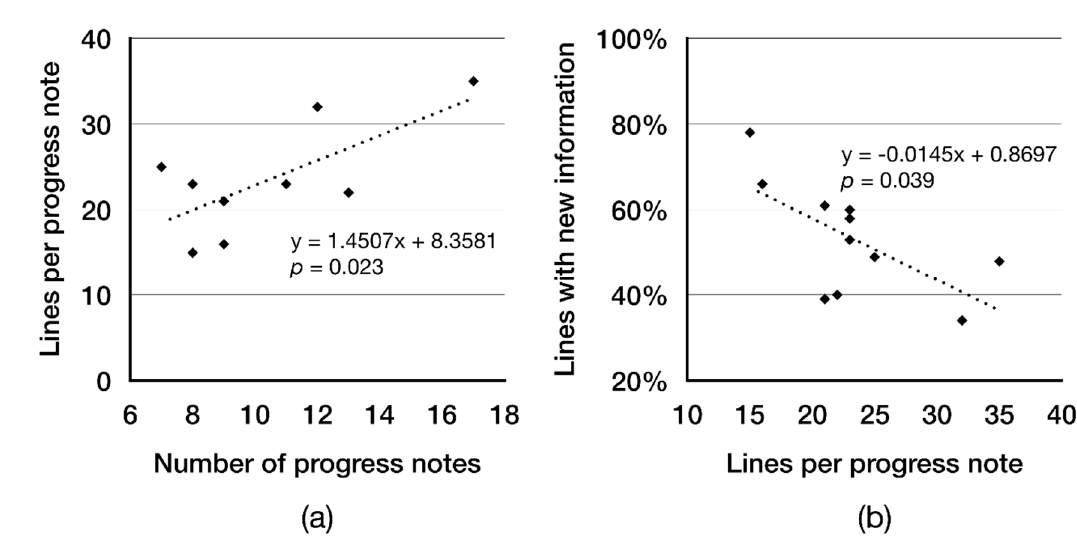
Figure 2. The relationship between lines per progress note and number of progress notes ( a ) and the relationship between lines with new information and lines per progress note ( b ).